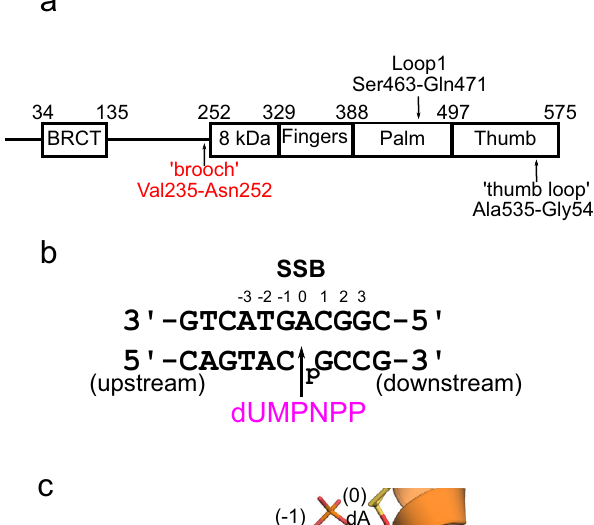
Fig. 4 Characterization of Pol λ ‘ brooch ’ -containing constructs with a 1nt- gapped SSB. a Domain organization of human Pol λ , with key structural features indicated. b 1nt-gapped SSB DNA substrate co-crystallized with the Pol λ catalytic domain containing the ‘ brooch ’ motif. For the pre- catalytic complex, the template (chain T, top), upstream primer (chain P, bottom left), and 5 ′ -phosphorylated downstream primer (chain D, bottom right) are pre-annealed and complexed with Pol λ and